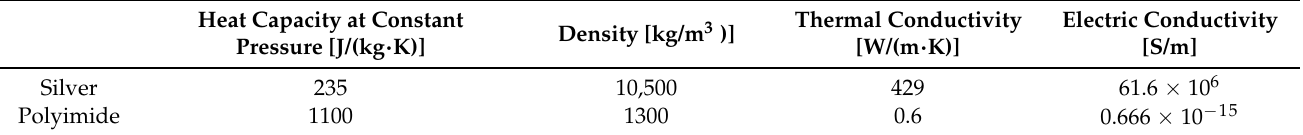
Table 2. Material Properties.